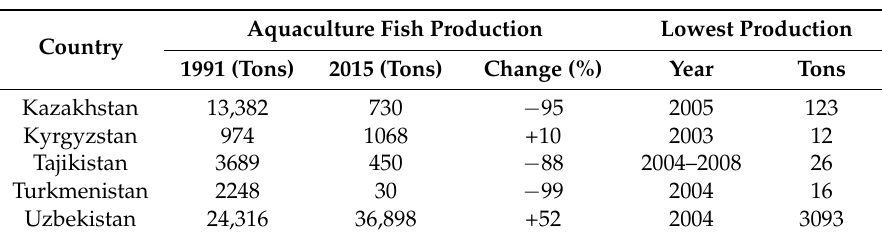
Table 1. Fish production in aquaculture from the collapse of the Soviet Union in 1991 to 2015 (Source: World Bank (www.worldbank.org).